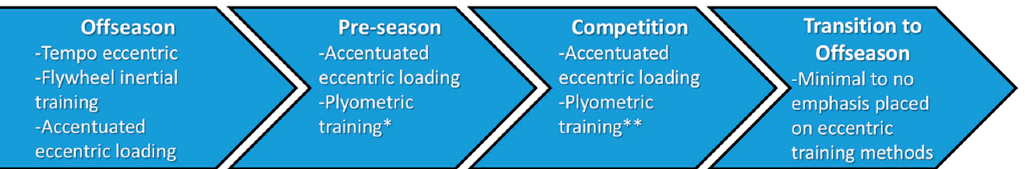
Figure 4. Recommended eccentric training methods based on the different phases of the training year.